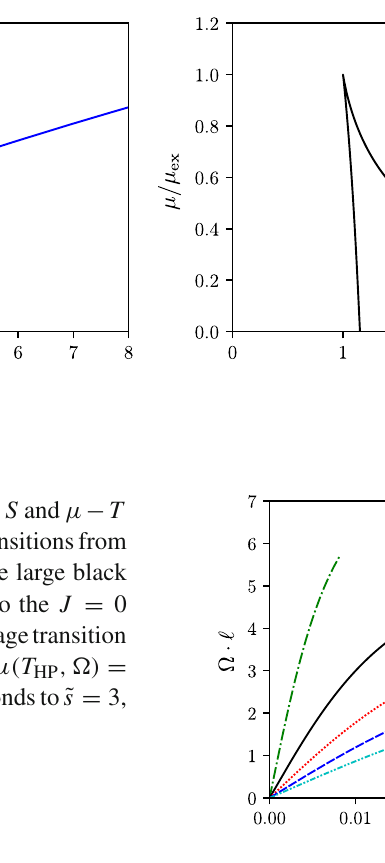
Fig. 4 (cid:5) − J curves at fixed S